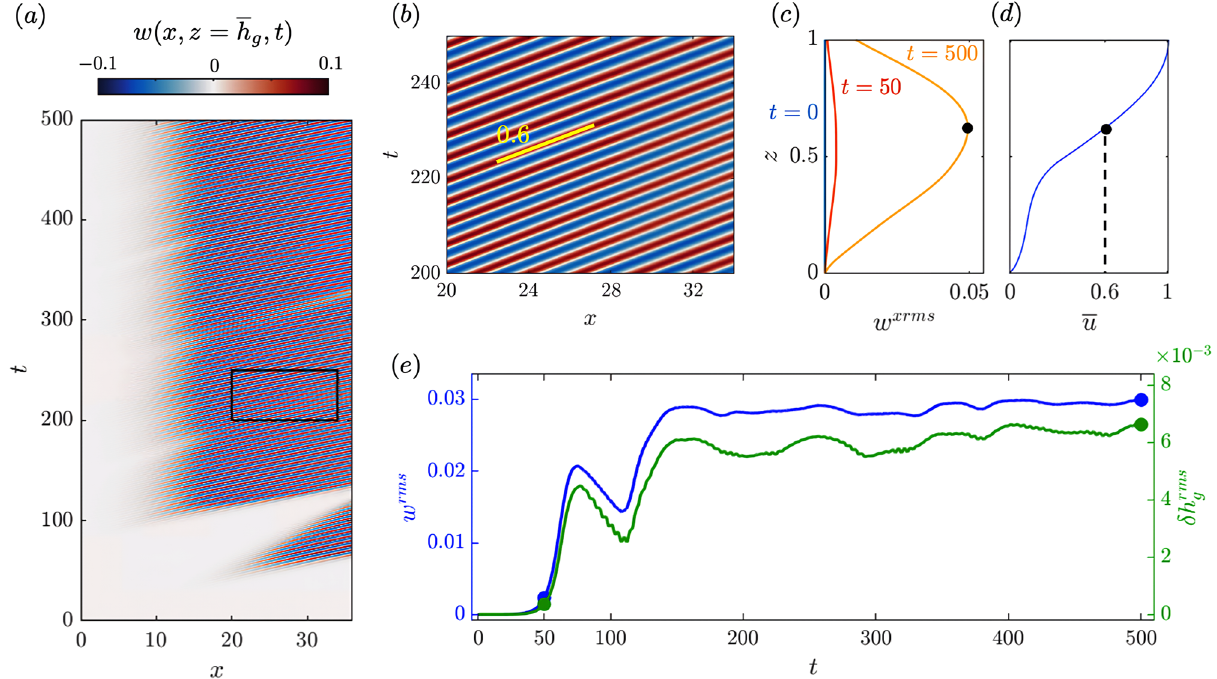
yellow line in ( b ) indicates a constant speed 0.6 of propagation of the perturbations. ( c ) Vertical velocity rms along x at t = 0 , 50, and 500. ( d ) Steady-state background horizontal velocity. ( e ) Time evolution of the spatial rms of w (blue) and ( h g − h g ) (green), identifying the instability onset and long-term behavior from both fluid and grass